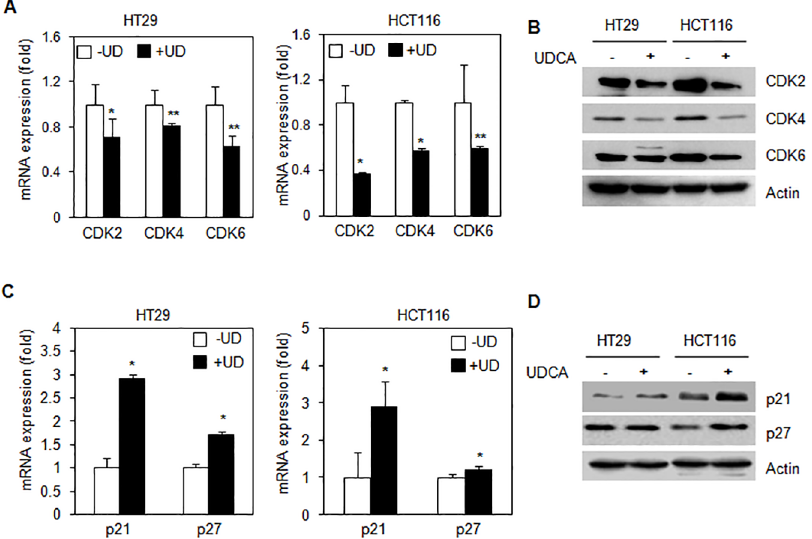
Fig 2. UDCA regulated levels of cell cycle related proteins. (A) mRNA expressionof cell cycle related protein was quantified by qRT-PCR from HT29 and HCT116cells with or without 0.2 mM UDCA for 24 h. (B) Decreased protein levels of cell cycle regulatorsin HT29 and HCT116 cells were observed over a 24h period by treatment with 0.2 mM UDCA. (C) mRNA levels of cell cycle inhibitorswere shown by qRT-PCR from HT29 and HCT116cells with and without treatment with 0.2 mM UDCA for 24 h. Error bars represent the standard deviation(SD); n = 3. (D) Protein levels of cell cycle inhibitorswere evaluatedby western blot from HT29 and HCT116cells with or without treatment with 0.2 mM UDCA for 24 h. Experiments were performed in triplicate. Asterisks indicate statistical significance (t < 0.05).